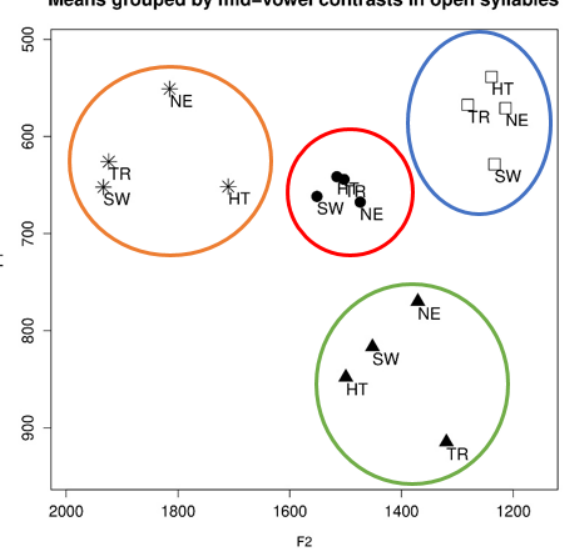
Figure 11. HM vowel means grouped by mid-vowel contrasts, incl. heritage speakers (star = front; filled dot = central; empty square = back; filled triangle = low).